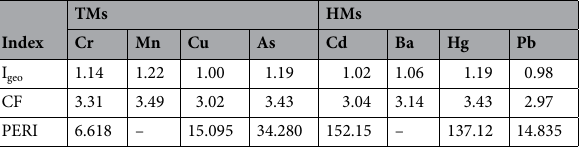
of wheat, and reduces the biomass in shoots and roots of cabbage 51 . The mean concentration of As in both soil and water samples did not exceed the limit recommended by the European Community (soil: 20 mg kg −1 ) and WHO (water: 0.01 mg kg −1 ) 52 . There was a linear relationship observed between the concentration of As in soil